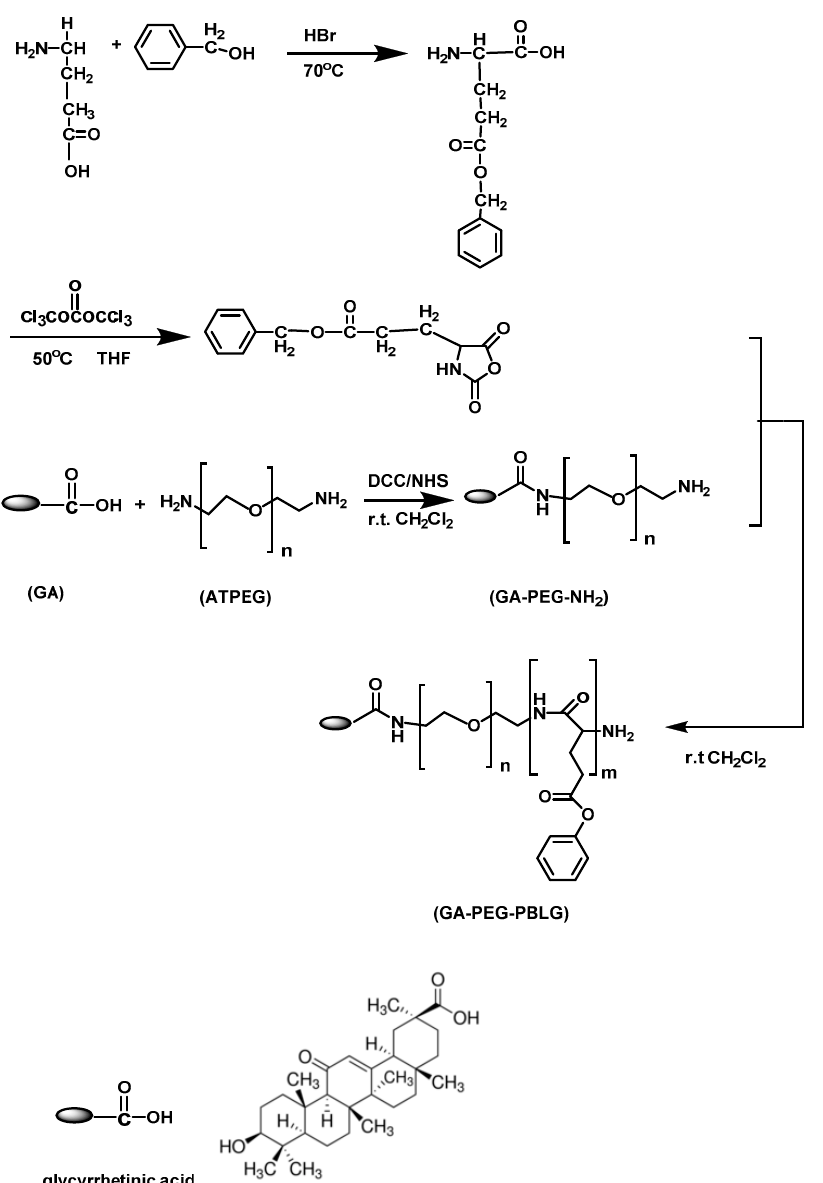
Figure 12. The reactions used for the synthesis of GA–PEG–PBLG block copolymers.